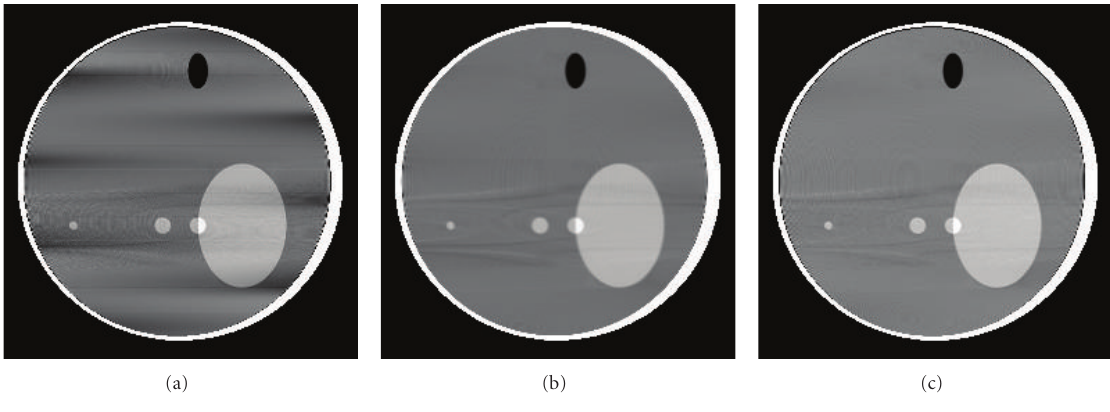
Figure 6: Slices of Shepp-Logan low-contrast phantom at x = 0. Illustration of axial intensity drop due to large value of pitch 0 . 5m in full-scan reconstruction (a) standard helical FDK. (b) HFDKW-1 algorithm and (c) HFDKW-2 algorithm. Display window is [1 1 . 04].